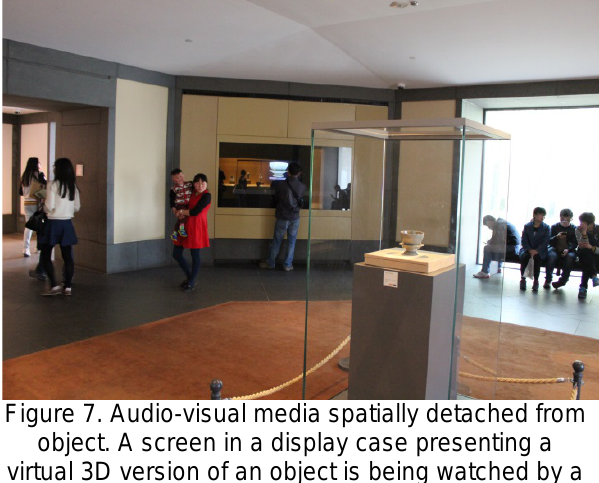
Figure 7. Audio-visual media spatially detached from object. A screen in a display case presenting a virtual 3D version of an object is being watched by a man in black, while a lady in red carrying a child is the only one actually looking at the original object in the foreground of the photo. Suzhou Museum, People's Republic of China. Photo: The author.